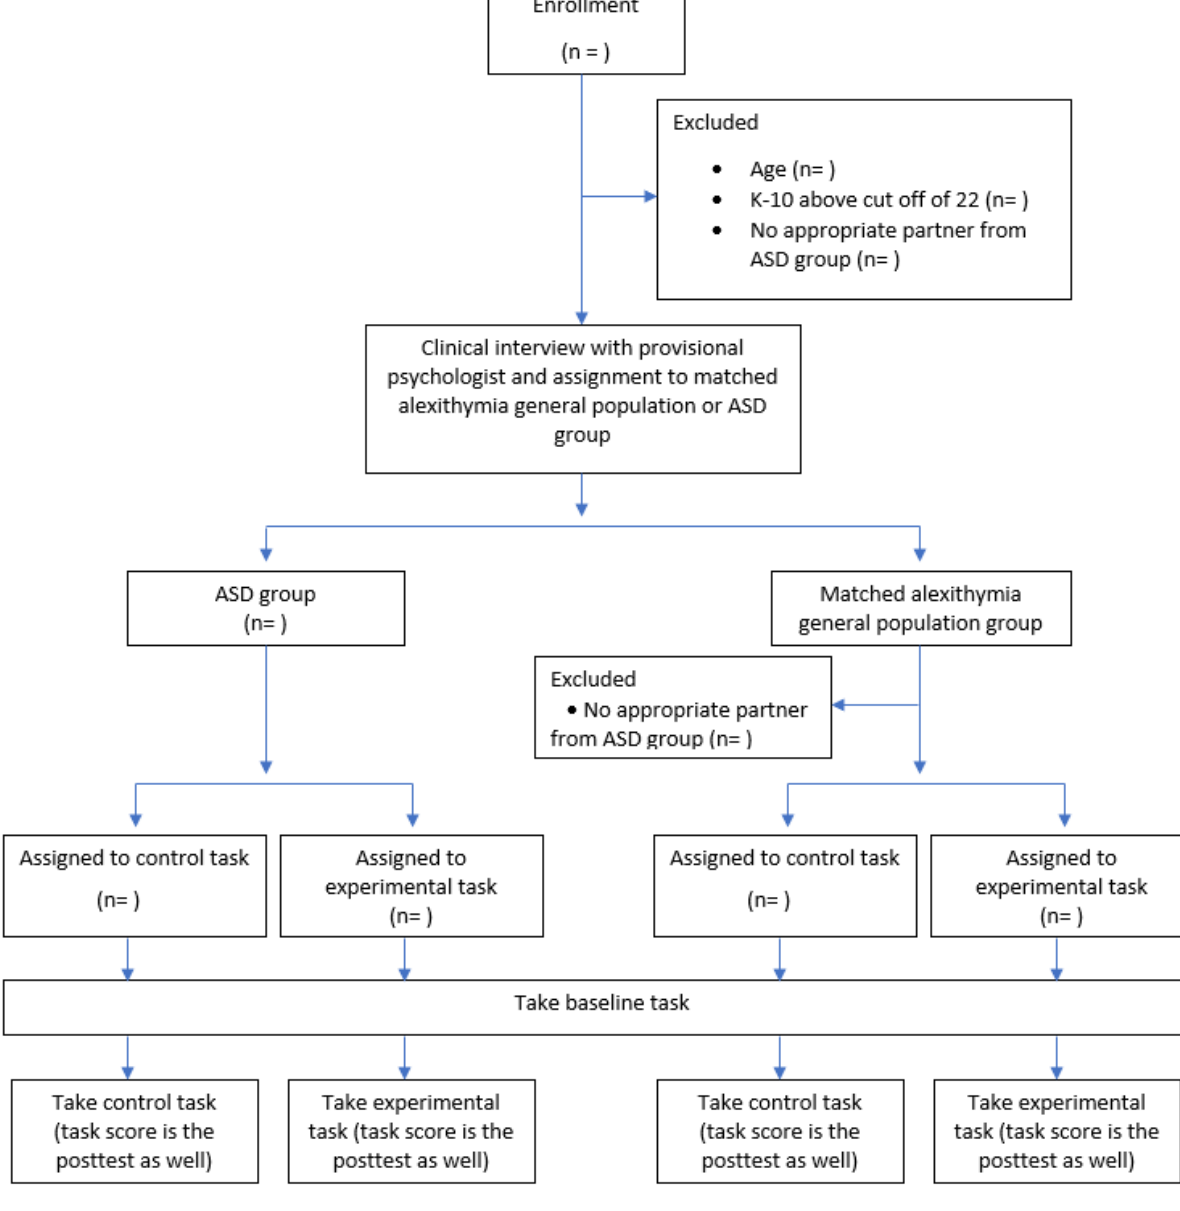
Figure 3. Participant flow diagram. ASD: autism spectrum disorder; K-10: Kessler Psychological Distress